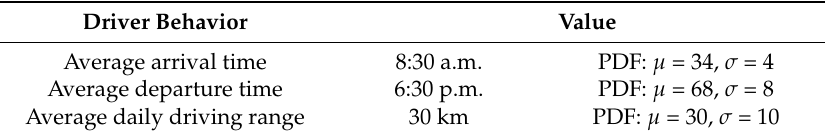
Table 5. Driver behavior; PDF: probability density function.